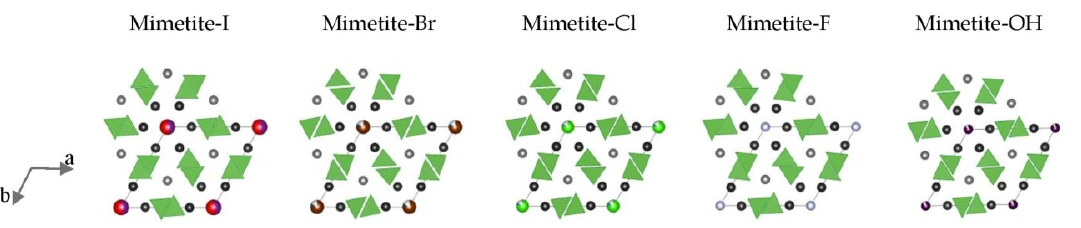
Figure 9. Topological representation of halogenated mimetites projected on (001). Black atoms are Pb(2), grey atoms are Pb(1), and the atoms at the corners of the unit cell represent the (001) projection of the I ‐ Br ‐ Cl ‐ F ‐ OH anion columns. For clarity, oxygen atoms are not shown, and the size of ions is not set to scale. The AsO 4 tetrahedra are emphasized to highlight the effect of twist angle φ .